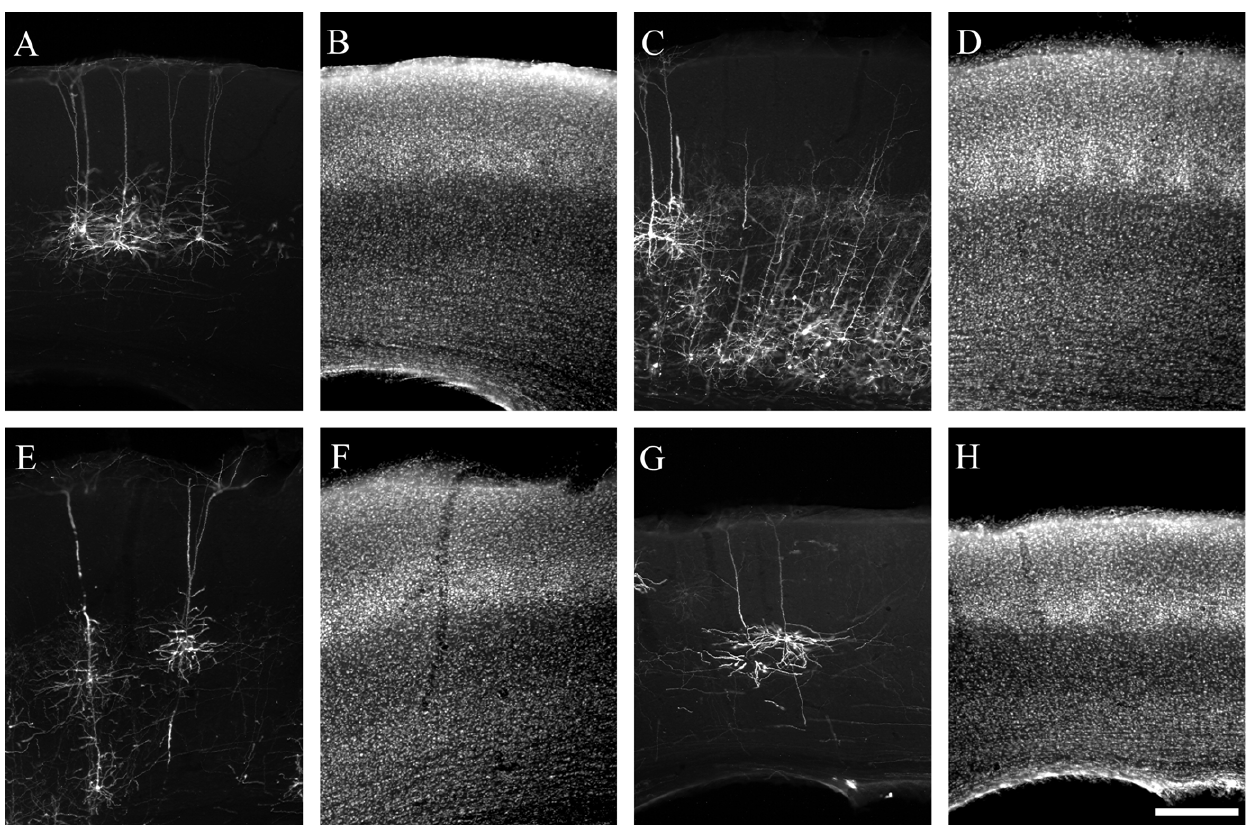
Figure 2. Photomicrographs illustrating typical labeling quality of pyramidal neurons using a glycoprotein-deleted rabies virus expressing EGFP. Pyramidal neurons are visualized by immunohistochemistry for EGFP and a Cy3-conjugated secondary antibody (A, C, E, G) and laminar borders are determined by a DAPI counterstain (B, D, F, H) . For all images the pial surface is towards the top. Neurons are retrogradely labeled from injections in the superior colliculus (A, B) , thalamus (C–F) , and contralateral S1 (G, H) . The neurons labeled from the superior colliculus are from the same animal as the example injection site in Figure 1B . The thalamic injection for panel C was too large to allow for reconstruction due to the density of label, but illustrates the difference in axonal arborizations with a large amount of axons present in the deep layers and almost no label in the superfi cial layers. The scale bar in H is 250 um and applies to all